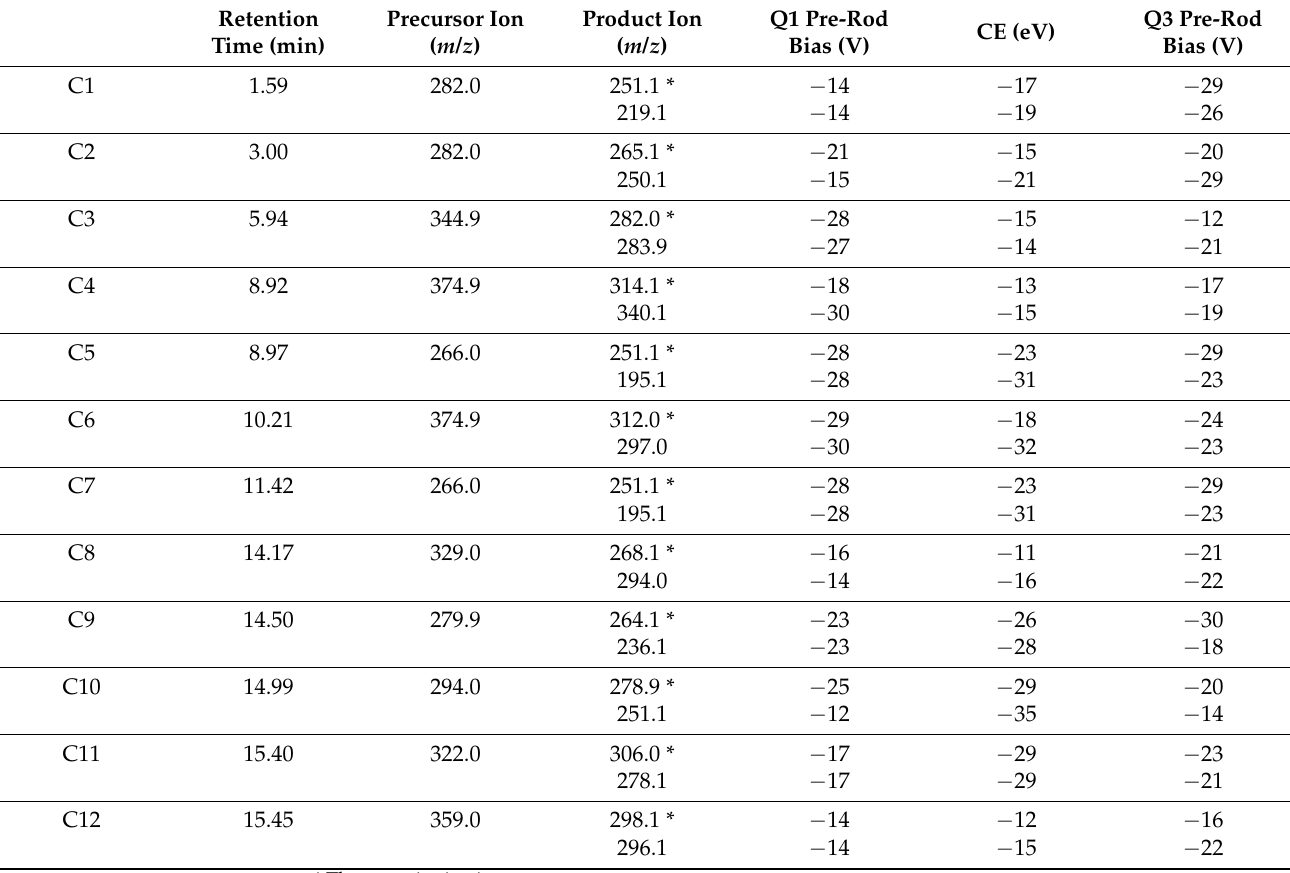
Table 4. Mass spectrometry